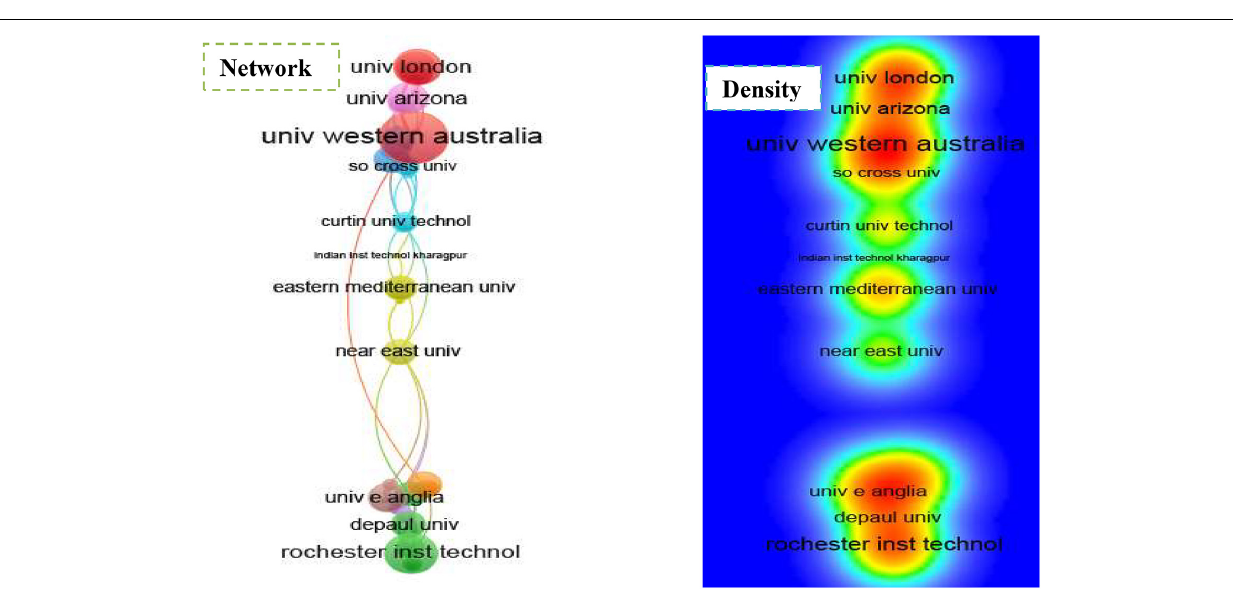
FIGURE 6 | The network and density of the most renowned research institutions in the field of quality of higher